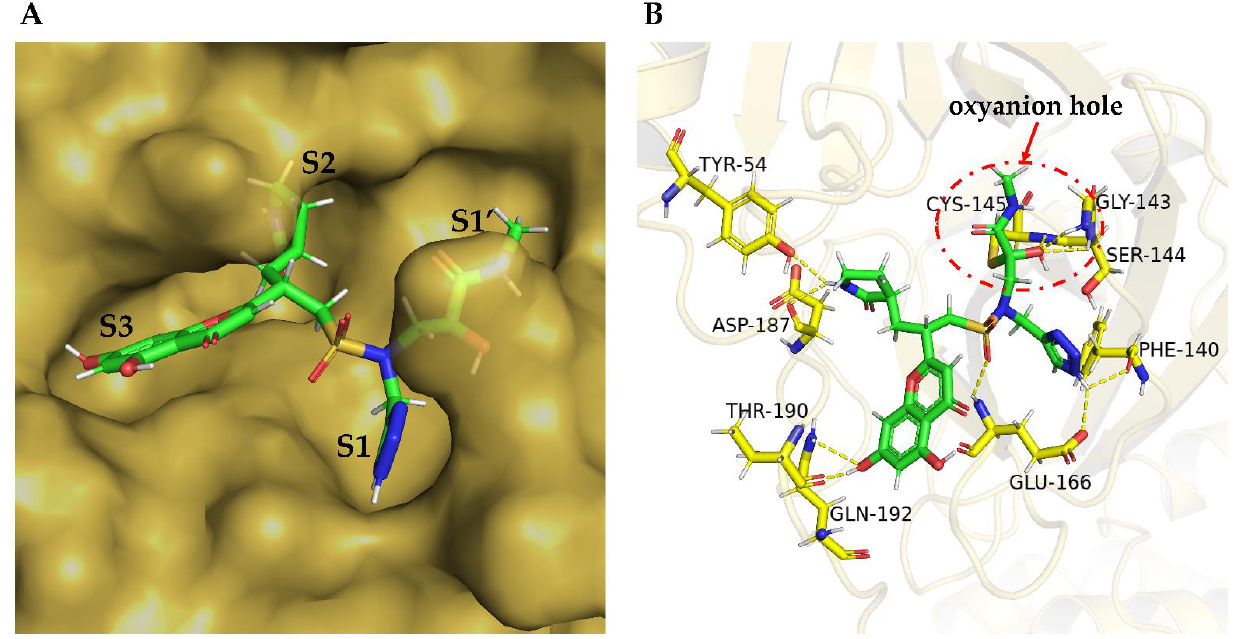
Figure 6. Covalent binding model of compound 46–14–3 in SARS-CoV-2 3CL pro . ( A ) Surface repre- sentation of SARS-CoV-2 3CL pro (brown) complexed with 46–14–3 (green sticks). ( B ) Stereoscopic view of 43–14–3 in the substrate-binding pocket of SARS-CoV-2 3CL pro at 4 Å. Molecule 43–14–3 is shown as green sticks. Residues forming H-bonds are shown as yellow sticks. Yellow dashes represent the H-bonds, and the oxyanion hole is in the red